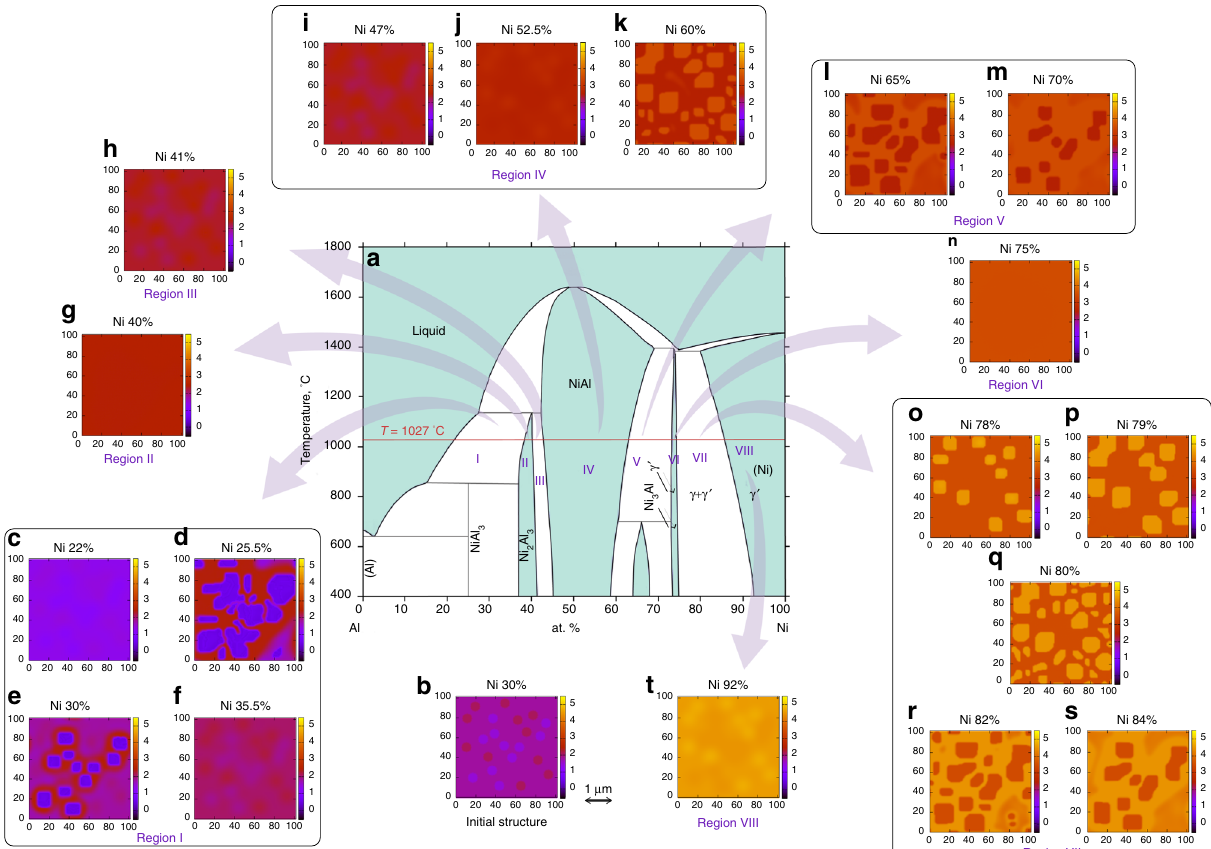
Fig. 5 Microstructures at various alloy compositions. a Temperature – composition phase diagram for Ni – Al alloy 14 . The compositions at which phase fi eld simulation results are shown falls on the T = 1027 °C line. b Plot of φ Ni at time t = 0 for composition Ni 1.2 Al 2.8 . Plot of φ Ni , calculated using our phase fi eld model after time step t = 10 5 ( t = 1.4 × 10 5 for ( o , p ) and t = 3 × 10 5 for ( d , e ) are shown for the compositions c Ni 0.88 Al 3.12 , d Ni 1.02 Al 2.98 , e Ni 1.2 Al 2.8 , and f Ni 1.42 Al 2.58 in region I; g Ni 2 Al 3 in region II; h Ni 1.64 Al 2.36 in region III; i Ni 1.88 Al 1.12 , j Ni 2.1 Al 1.9 , and k Ni 2.8 Al 1.2 in region IV; l Ni 2.6 Al 1.4 and m Ni 2.8 Al 1.2 in region V; n Ni 3 Al in region VI; o Ni 3.12 Al 0.88 , p Ni 3.16 Al 0.84 , q Ni 3.2 Al 0.8 , r Ni 3.28 Al 0.72 , and s Ni 3.36 Al 0.64 in region VII, and t Ni 3.68 Al 0.32 in region VIII. The corresponding values of Ni % is written on top of each plot. The length scale, given here is a guideline for the readers to have a rough estimation and obtained by comparing with the microstructures as in ref.